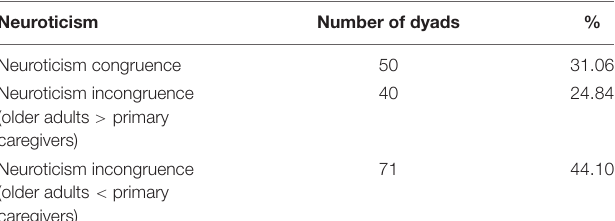
TABLE 4 | Correlation coefficients of variables ( n =